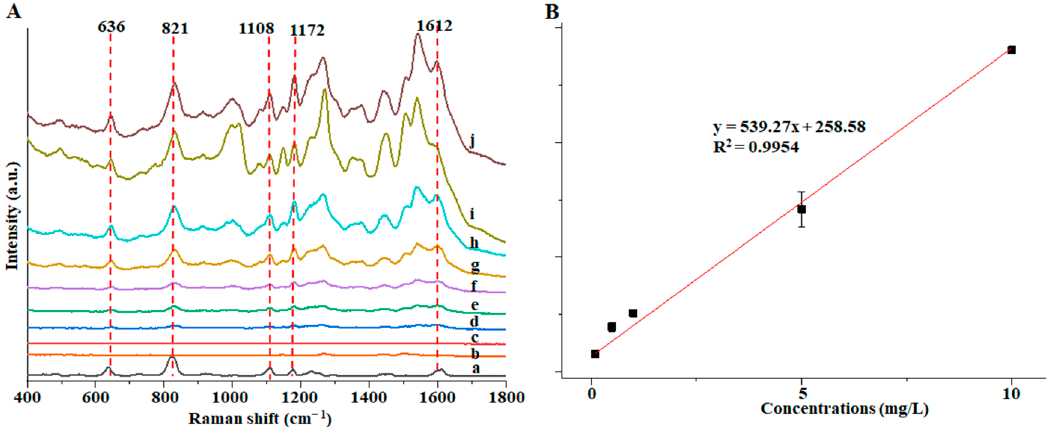
Figure 6. ( A ) SERS spectra of BPA in the solid state (a), in methanol (b), and in 0.05 (c), 0.1 (d), 1 (e), 5 (f), 10 (g), 25 (h), 50 (i) and 100 (j) mg/L Au@ZIF-8 solution; ( B ) Intensity of the BPA peak at 1172 cm − 1 as a function of BPA concentration (0.05, 0.1, 1, 5 and 10 mg/L).